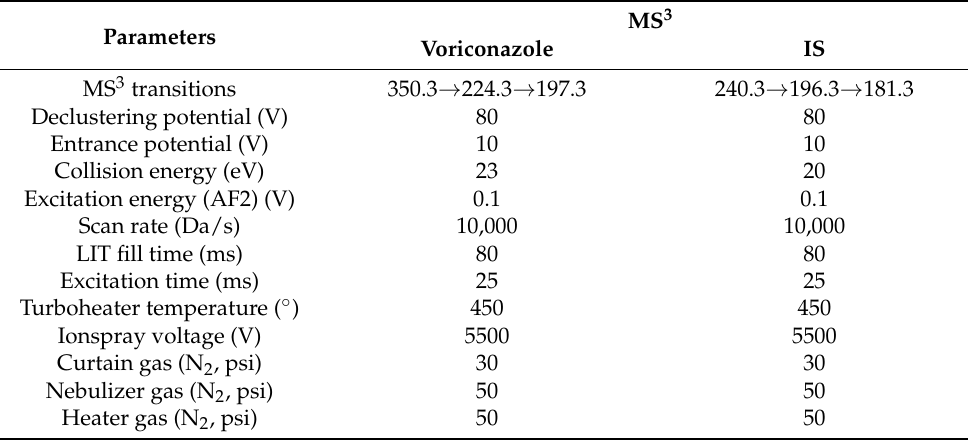
Table 1. Optimized parameters for quantitation of voriconazole using LC-MS 3 .